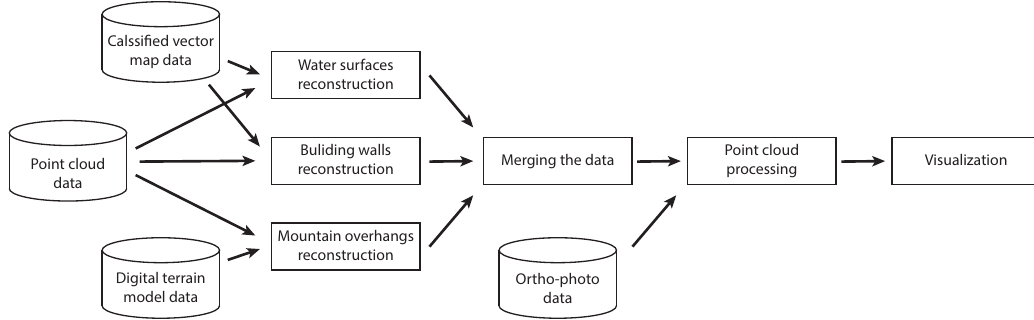
Figure 2. The outline of the point-cloud augmentation pipeline that shows how different input modalities are used for augmenting the point-cloud.